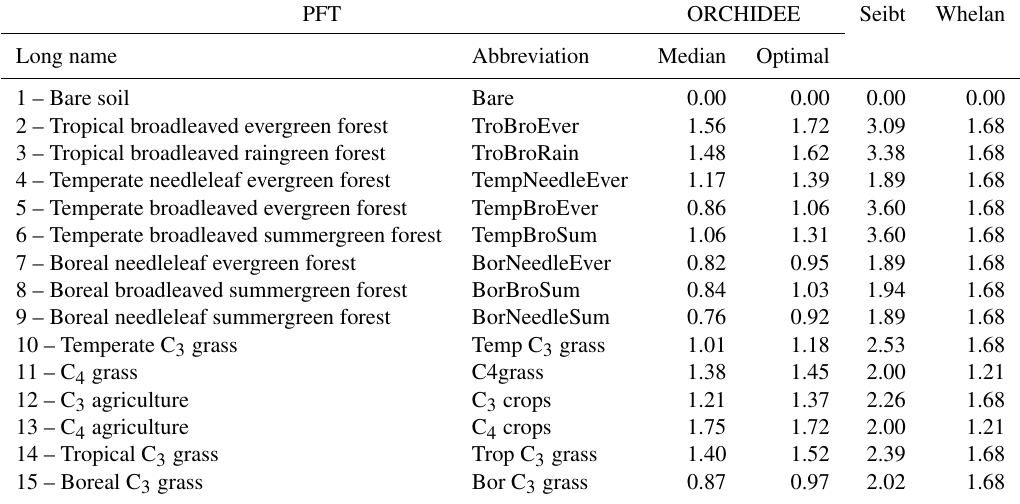
Table 1. Table of LRU per PFT. First column: median and optimal LRU values calculated from the simulated mechanistic COS and GPP fluxes. Middle columns: calculated from Seibt et al. (2010) for the ORCHIDEE PFT classification. Last column: from Whelan et al. (2018). PFT